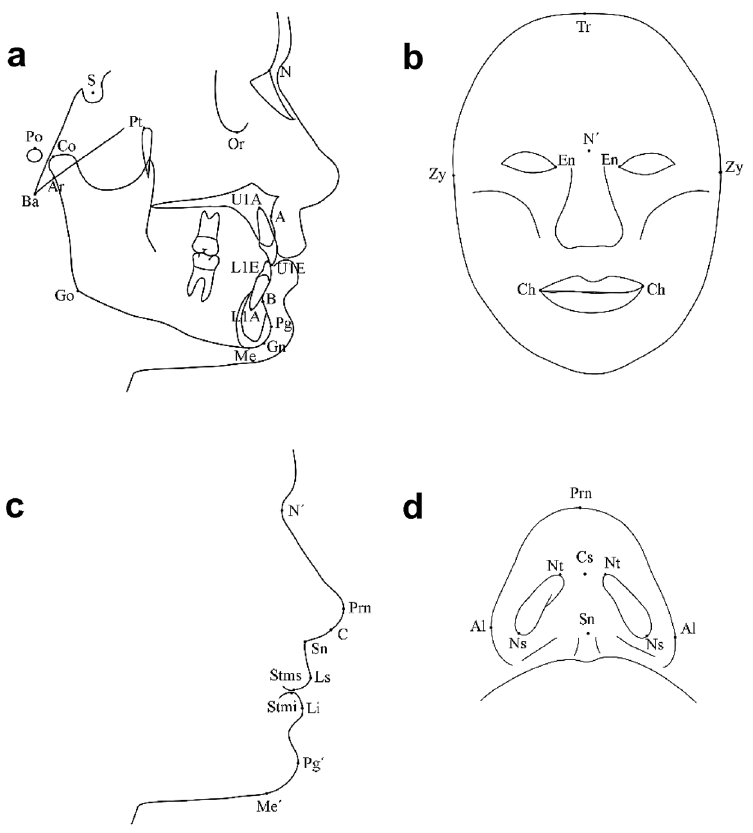
Figure 2. Landmarks on the lateral cephalogram ( a ) and frontal ( b ), lateral ( c ), and submental ( d ) facial photographs. A A point, Al alare, Ar articulare, B B point, Ba basion, C columella, Cs columella superius, Ch cheilion; Co condylion, En endocanthion, Go gonion, Gn gnathion, L1A lower central incisor apex, L1E lower central incisor edge, Li labrale inferius, Ls labrale superius, Me menton, Me ′ soft tissue menton, N nasion, N ′ soft tissue nasion, Ns nostril sill, Nt nostril tip, Or orbitale, Pg pogonion, Pg ′ soft tissue pogonion, Prn pronasale, Po porion, Pt pterygoid, S Sella, Sn subnasal, Stmi stomion inferior, Stms stomion superior, Tr trichion, U1A upper central incisor apex, U1E upper central incisor edge, Zy